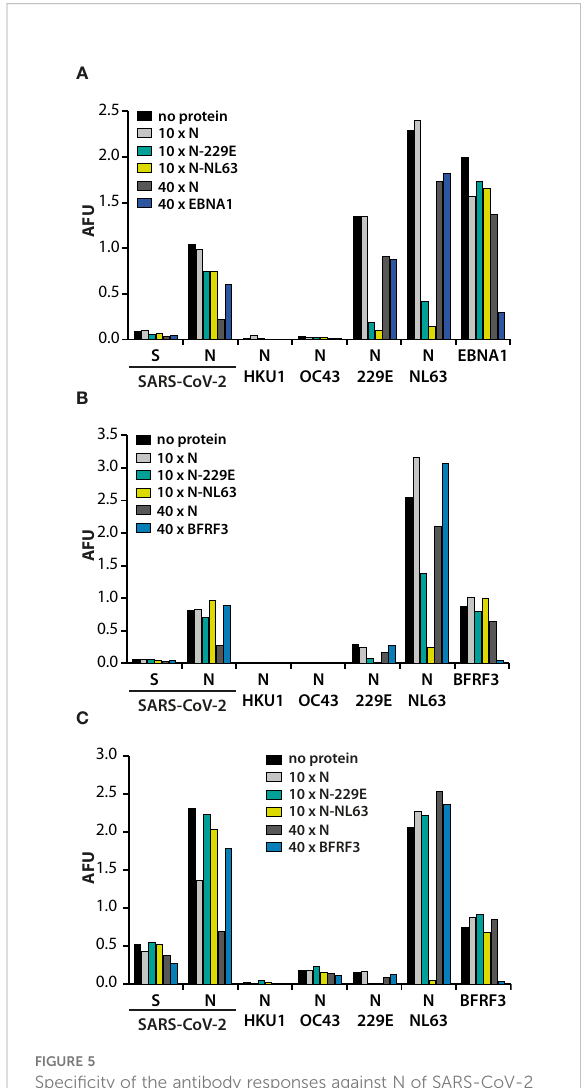
FIGURE 5 Speci fi city of the antibody responses against N of SARS-CoV-2 and the alphacoronaviruses. Serum samples of three SARS-CoV- 2 infected donors (A – C) were either left untreated (no protein), or supplemented with the indicated proteins in a 10- or 40-fold excess of the amount spotted on the membranes and then probed against S and N of SARS-CoV-2, as well as the N proteins of the endemic HCoVs. Antibody responses against BFRF3 and EBNA1 were included as controls, depending on the previously established, individual response